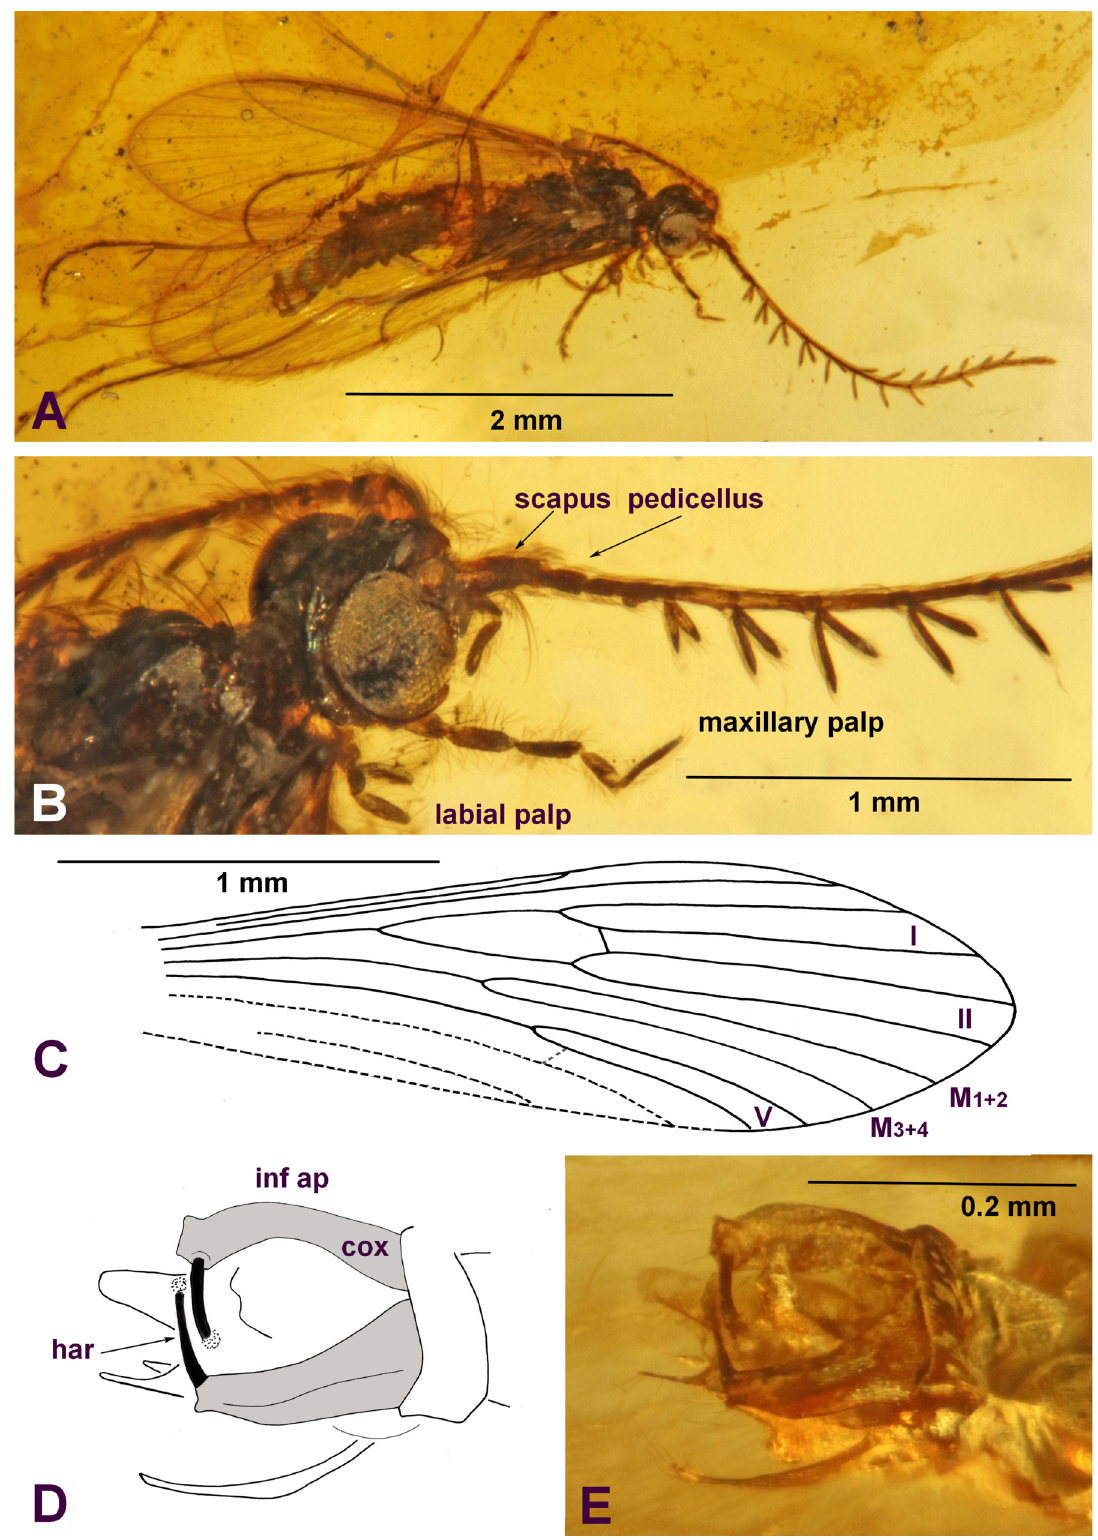
Fig. 3. Palaeopsilotreta cretacea sp. nov. (ZFMK-TRI000814) A . Holotype male in dorsal view. B . Head with bipectinate antennae, maxillary palps and labial palps. C . Drawing of a forewing. D . Drawing of the male genitalia. E . Male genitalia in ventral